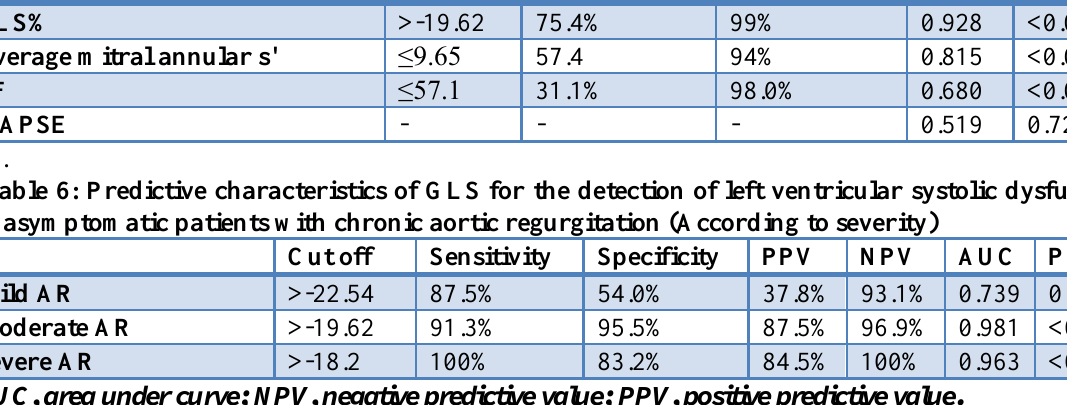
AUC, area under curve; NPV, negative predictive value; PPV, positive predictive